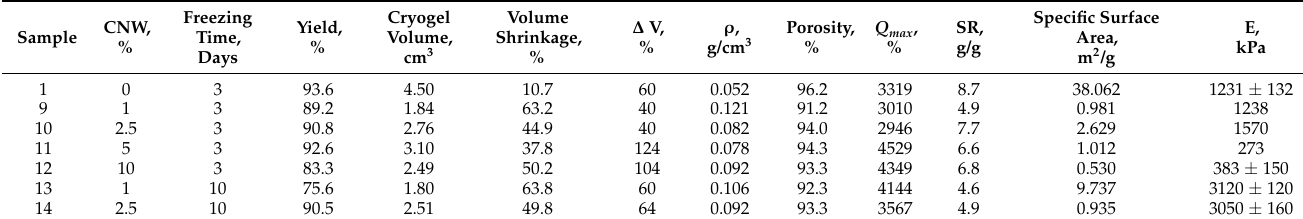
Table 5. Conditions of the production process and the characteristics of composite